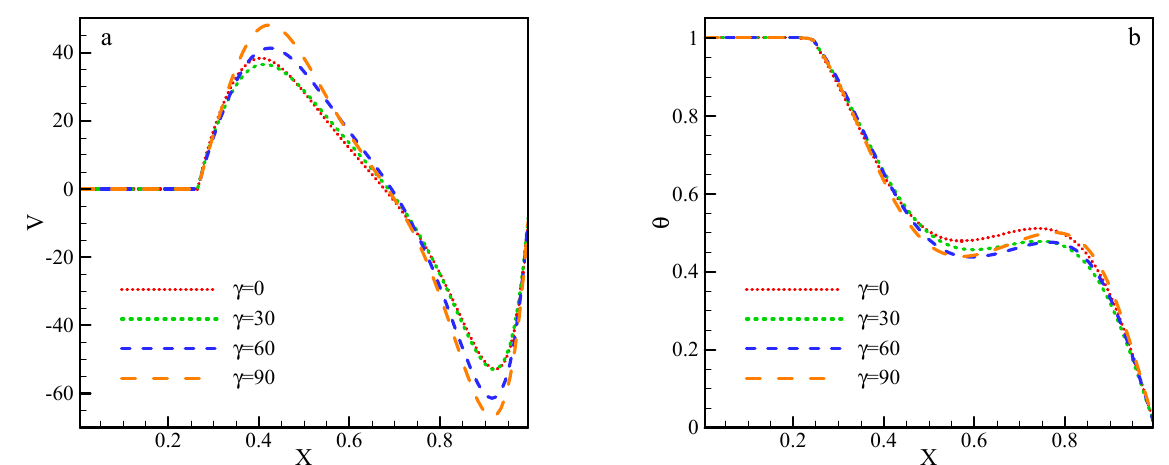
Figure 11. Dimensionless velocity ( a ) and dimensionless temperature ( b ) at Y = 0.5 for Ra = 10 5 , Rd = 1, Ha = 20, AR = 0.45 − 0.6, ω = 0, ϕ = 0.03, and various MGF angles.